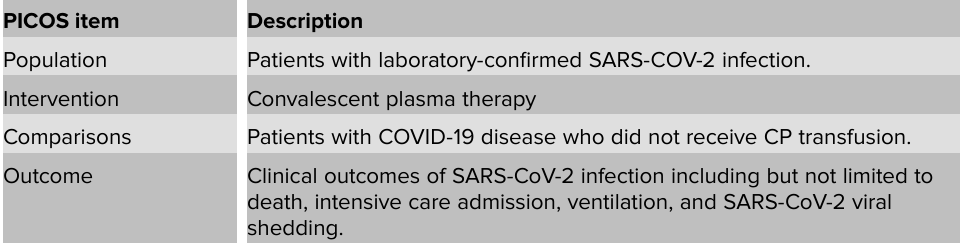
TABLE 1: PICOS items: formation of the review